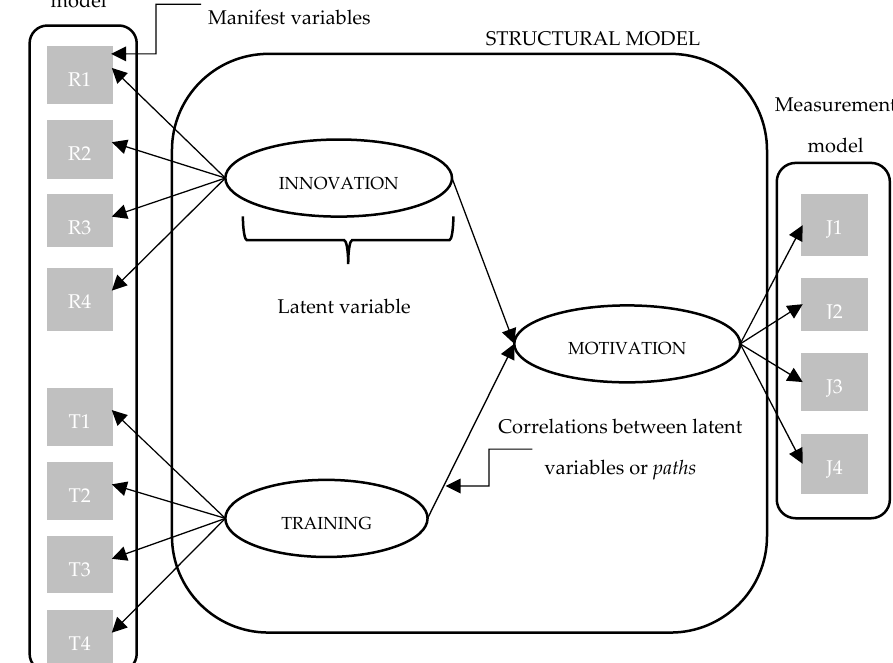
Figure 2. PLS Structure.